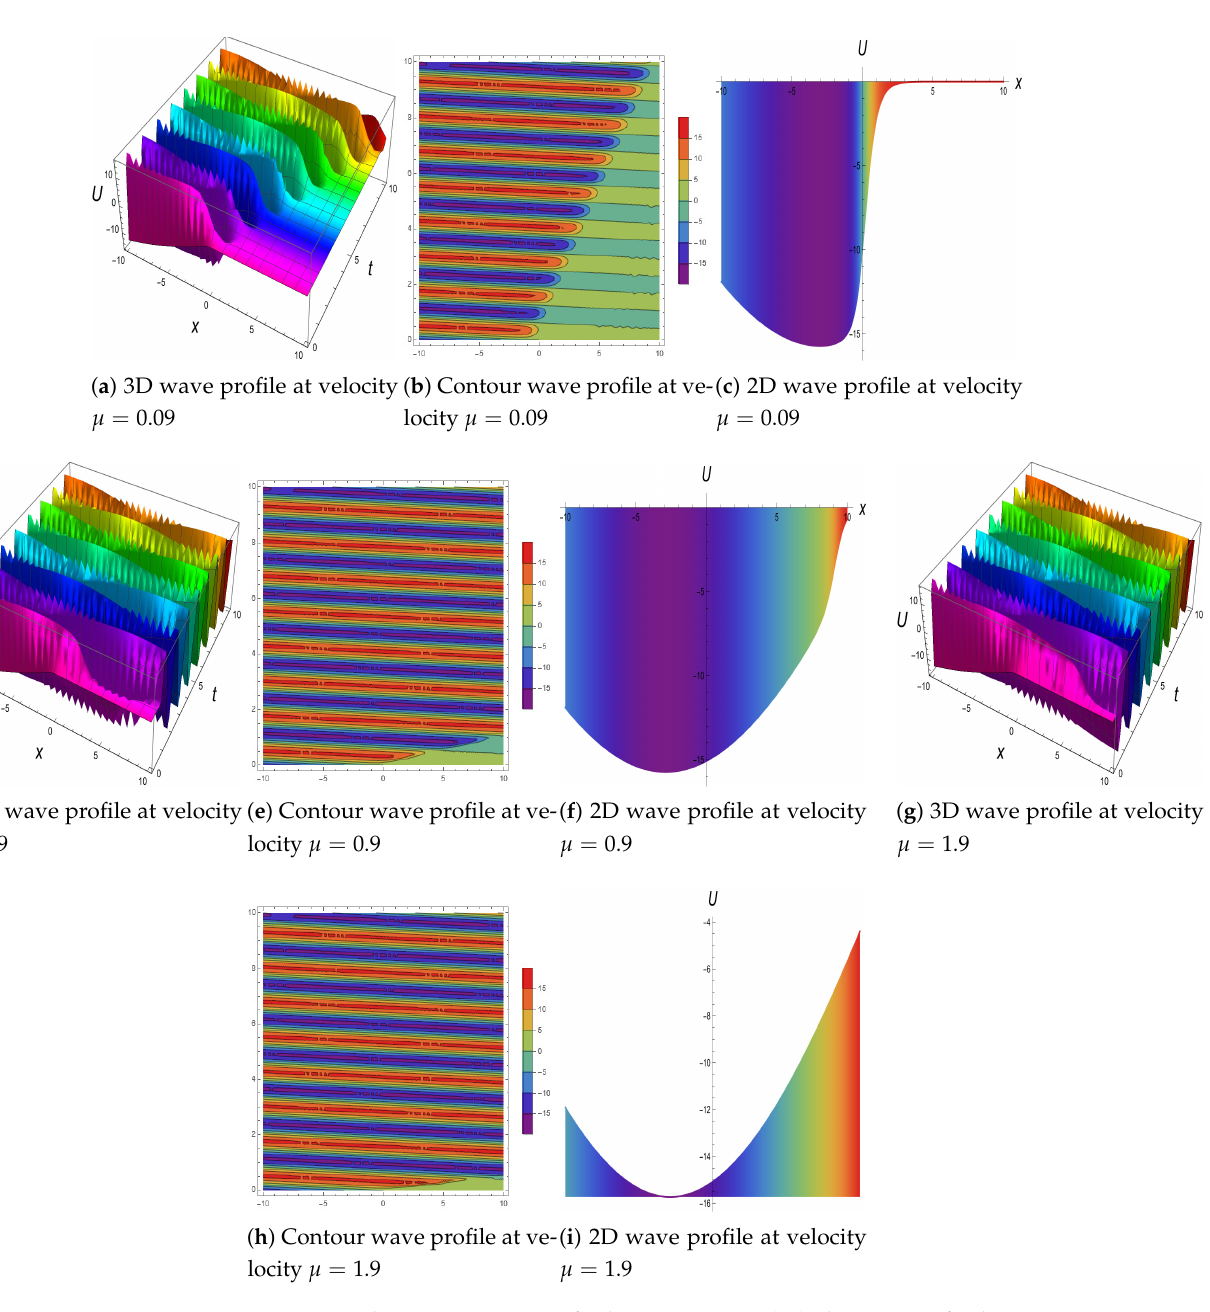
Figure 6. For the Imaginary part of solution Equation (98), the impact of velocity is seen in 3D, 2D, and contour